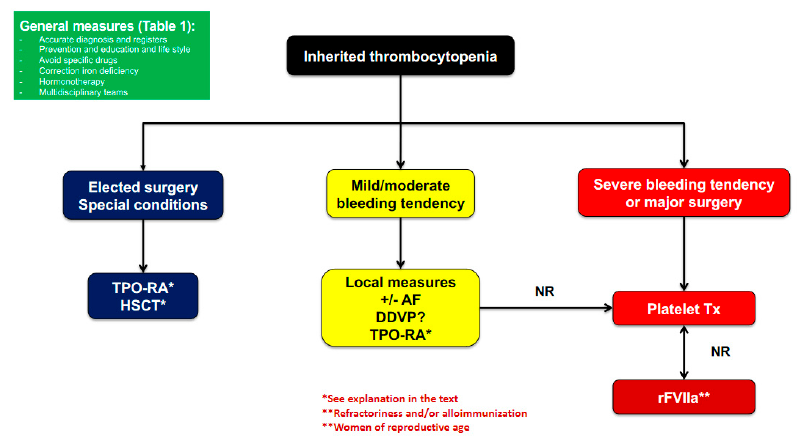
Figure 2. General algorithm to the management of thrombocytopenia and bleeding in IT. TPO-RA could be a reasonable option for IT with cytoskeleton protein alteration and proplatelet formation, or reduced life span. Short-term eltrombopag is a valuable treatment for MYH9-RD in reduced bleeding symptoms and before surgery. Romiplostim could be used for a bridging therapy in WAS patients before HSCT. HSCT is considered a curative option in severe forms of IT. Abbreviations: AF: antifibrinolytics; TPO-RA: Thrombopoietin receptor agonist; Tx: transfusions; HSCT: